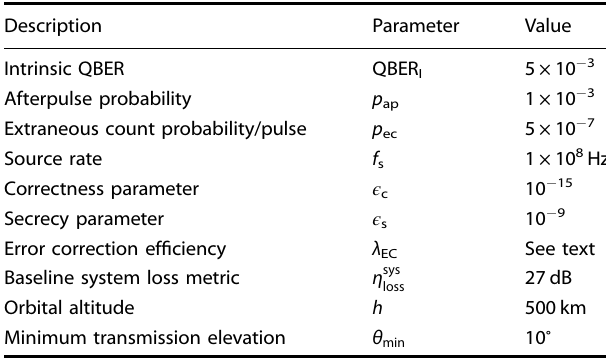
Table 1. Baseline SatQKD system parameters. λ EC depends on block size and QBER I = 0.5% is consistent with Micius results 19